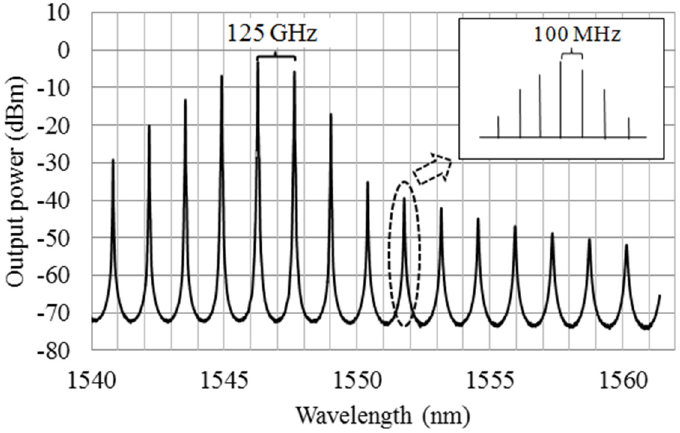
Figure 2. Optical spectrum of multilongitudinal modes due to 324-µm-long active-gain region and 1-m-long fiber cavity.